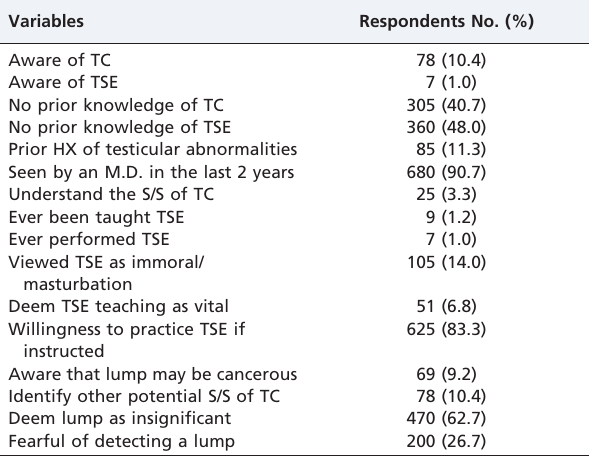
Table II - Knowledge/Awareness Of TC And TSE Practice.